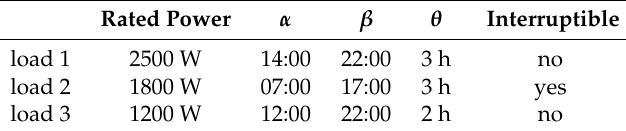
Table 4. Schedulable loads of User